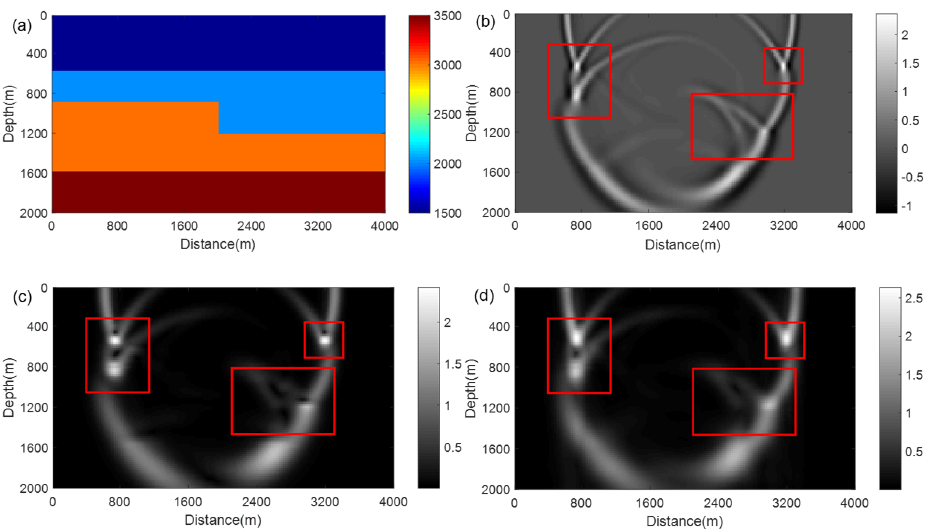
Figure 1. Envelope field calculated by different methods. ( a ) Velocity model. ( b ) Wavefield snap- Scheme 1 s. ( c ) Envelope field calculated by conventional method at 1 s. ( d ) Envelope field calculated by the proposed method at 1 s. Red rectangulars show the comparison areas.